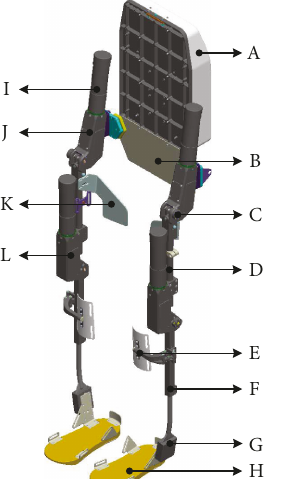
Figure 2: Mechanical structure of the SIAT exoskeleton robot. A: backpack with controller and battery; B: waist part; C: encoder; D: thigh segment whose length is adjustable; E: ba ffl e of knee joint; F: shank segment whose length is adjustable; G: ankle joint; H: wearable shoes; I: DC motor; J: hip joint; K: ba ffl e of buttock; and L: knee joint.